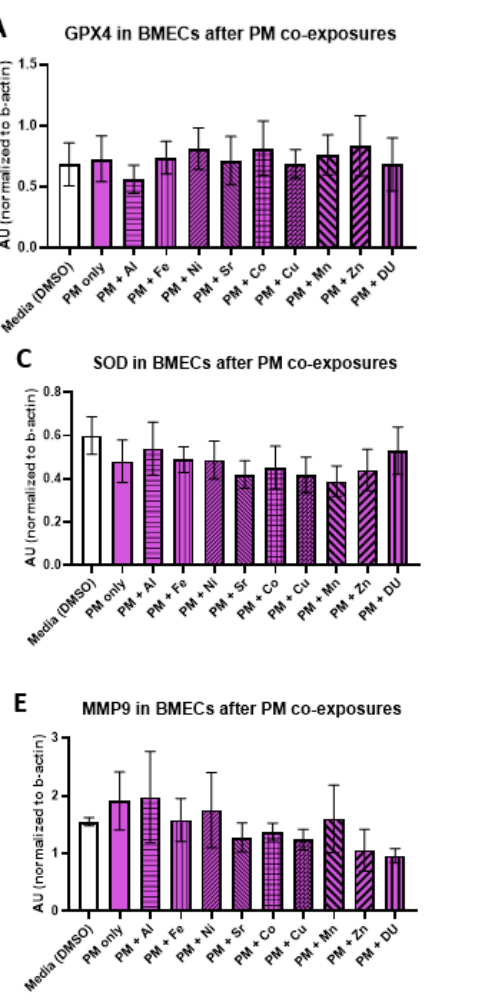
( B ) catalase expression, ( C ) SOD expression, ( D ) MMP3 expression, and ( E ) MMP9 expression. All assessments are from the same experiment setup—each protein run is completed from the same homogenized sample cell pellets. PB alone is compared to media alone, and then each PB + metal group is compared to PB alone. Data represent the mean and standard deviation of three independent experiments.